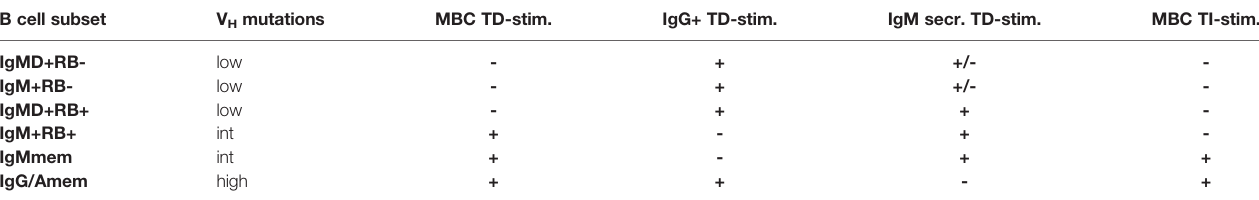
TABLE 1 | Summary of B cell subset discriminating factors. B cell subset V H mutations MBC TD-stim. IgG+ TD-stim. IgM secr. TD-stim. MBC